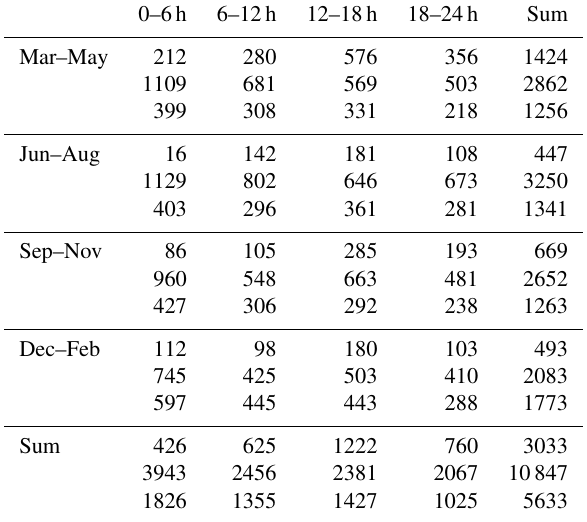
Table 2. Number of determined growth periods segregated by time of year (rows), times of day (columns) and aerosol size modes (top: nucleation mode, middle: Aitken mode, bottom: accumulation mode). Note that the segregation to modes is made based on the starting size of the observed growth